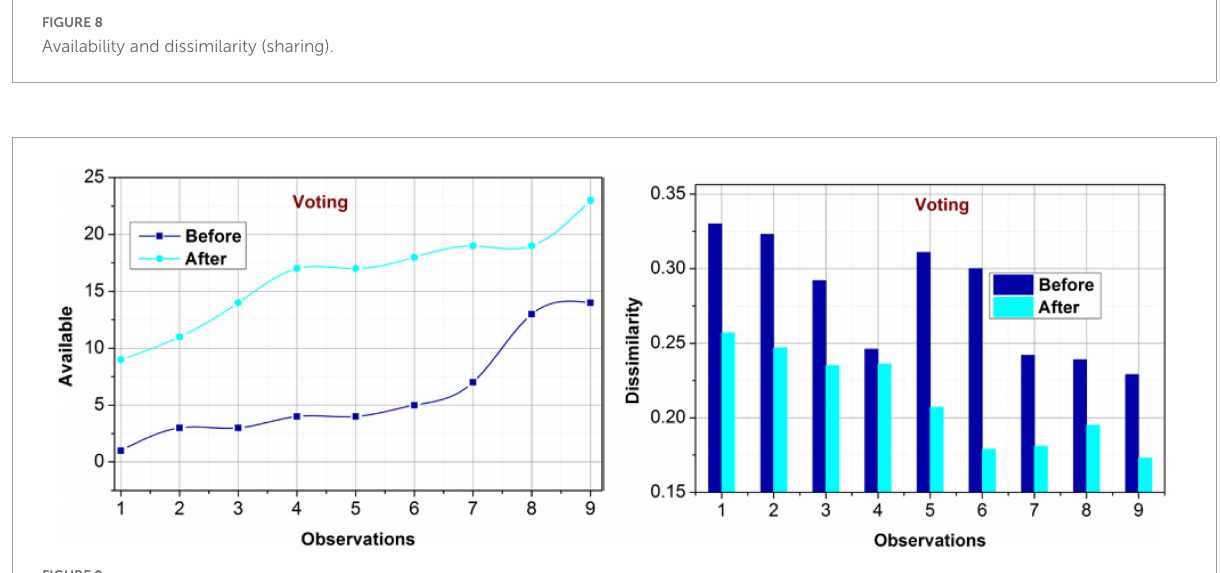
FIGURE9 Availability and dissimilarity